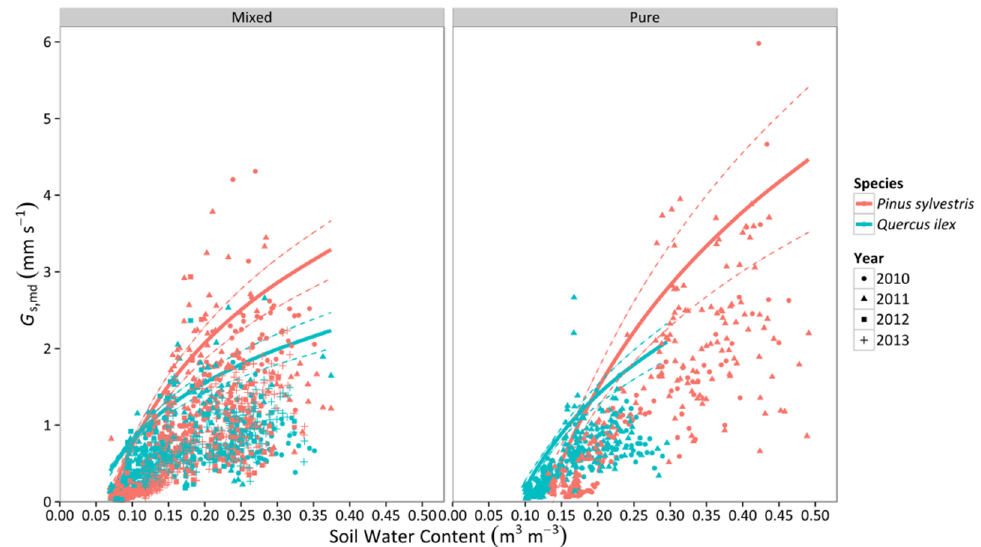
Figure 3. Relationship between predawn leaf water potential ( Ψ PD ) and midday leaf water potential ( Ψ MD ) throughout three years of measurements for P. sylvestris and Q. ilex trees. Error bars indicate ±1 SE. The 1:1 line is also depicted. Linear regression lines are also depicted for each species. The intercept ( λ ) and the slope ( σ ) of the relationship are shown in the insert.